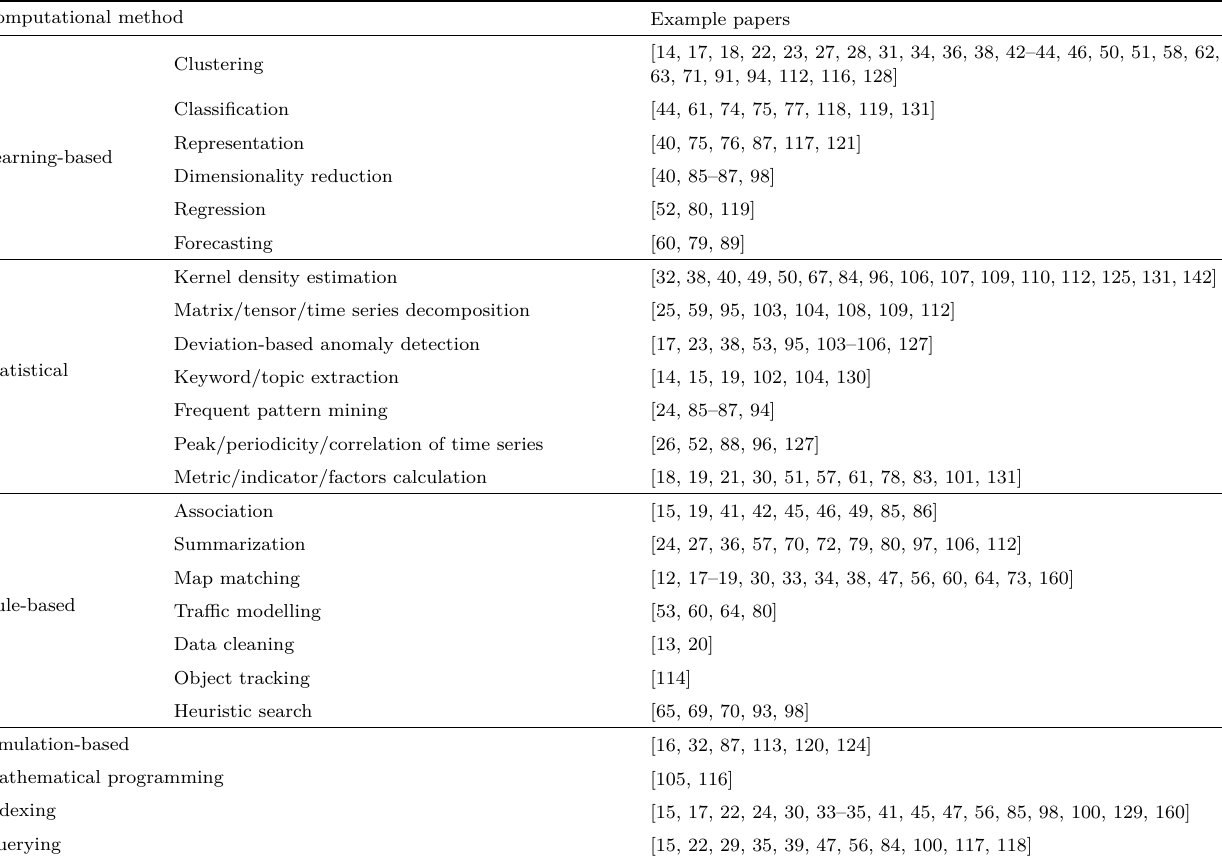
Table 4 Computational methods in urban visual